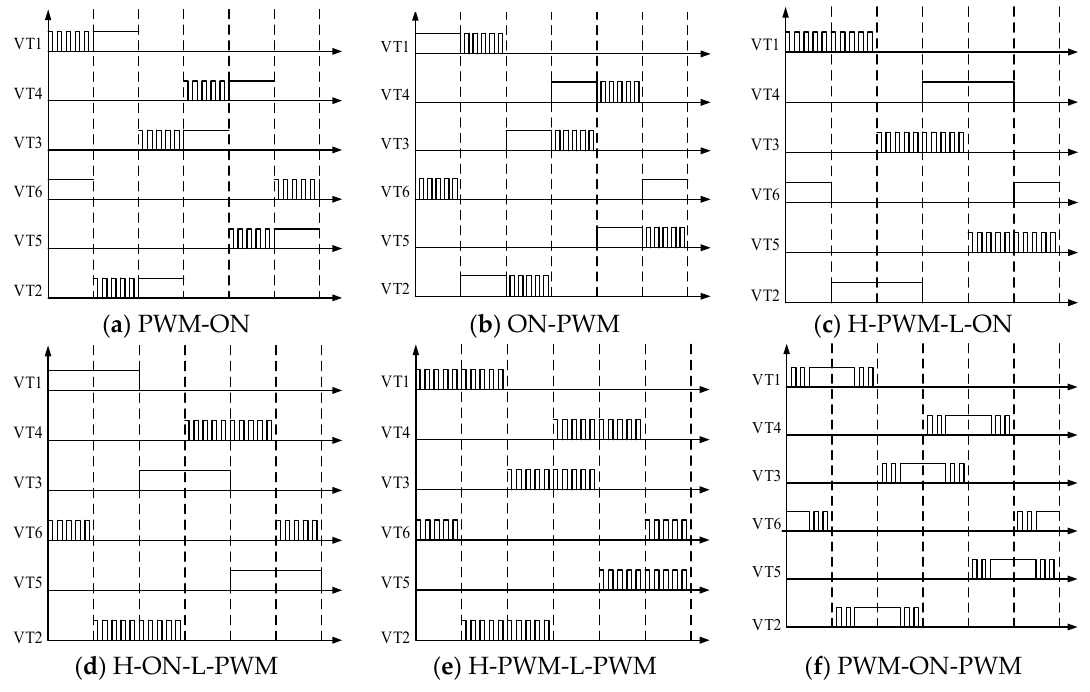
Figure 9. Six commonly used PWM-control methods. PWM: pulse-width modulation.